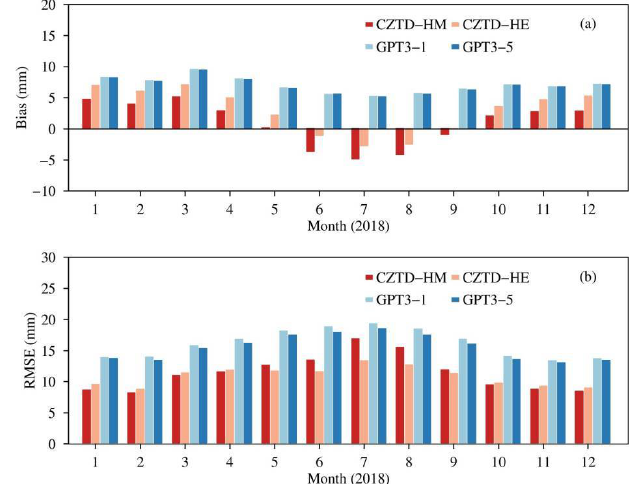
Figure 8. Bias and RMSE of spatial interpolation for GGOS gridded ZTD for CZTD-H and GPT3 models in different months validated by GNSS data. models in different months validated by GNSS